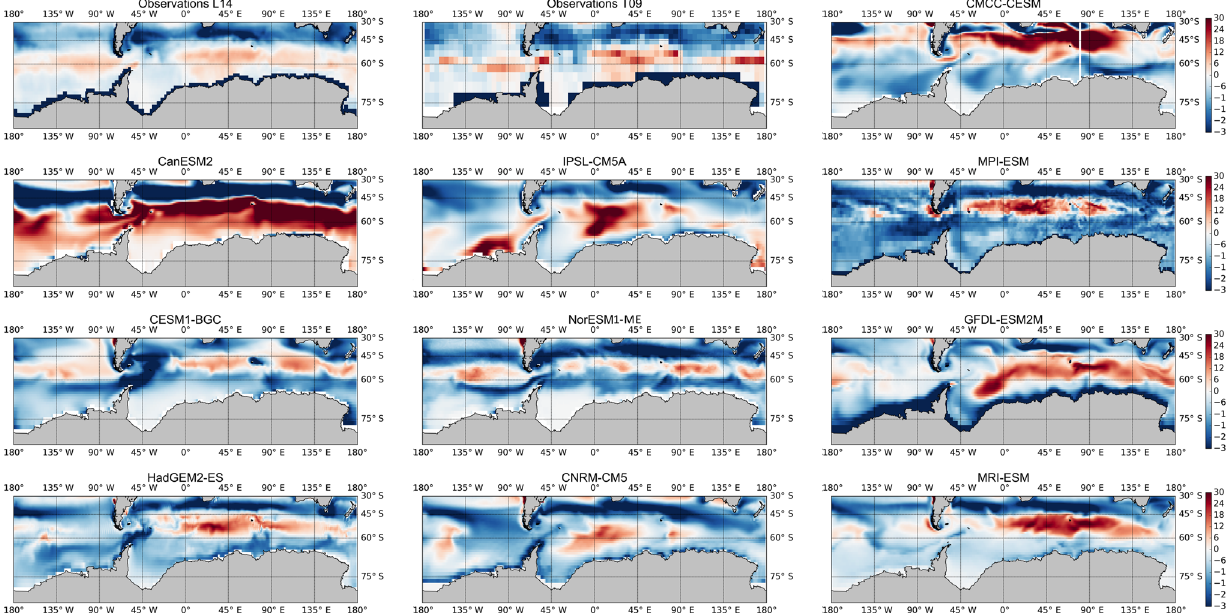
Figure 1. The annual mean climatological distribution sea–air CO 2 flux ( F CO 2 , in gCm − 2 yr − 1 ) for observations (L14: Landschützer et al., 2014; T09: Takahashi et al., 2009) and 10 CMIP5 models over 1995–2005. CMIP5 models broadly capture the spatial distribution of F CO 2 with respect to L14 and T09; however, they also show significant differences in space and magnitude between the basins of the Southern Ocean, with a few